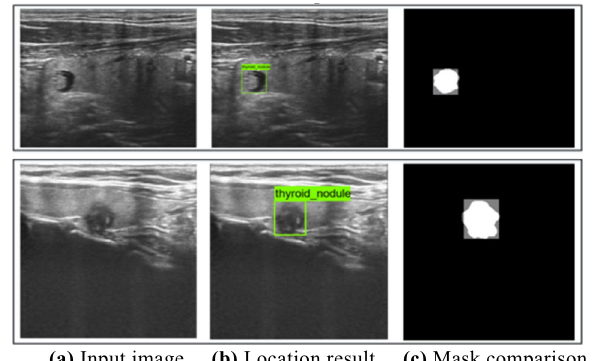
Figure 10. Positioning effect.